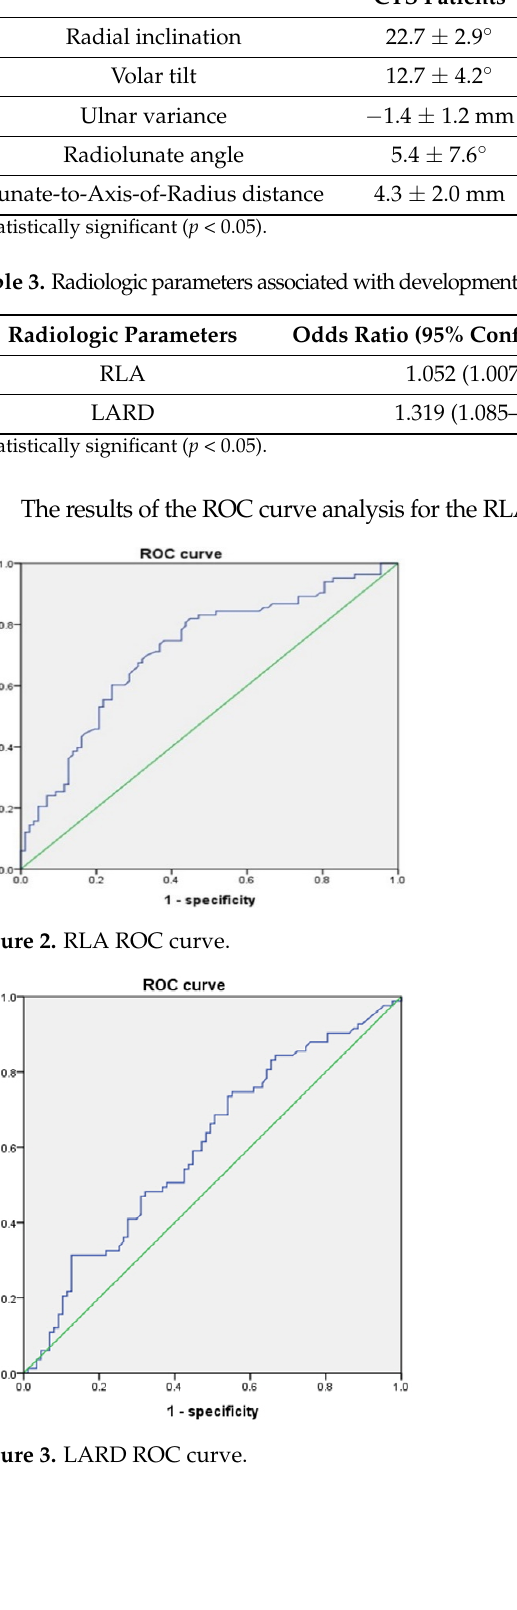
Table 2. Results of radiological parameters of each group.